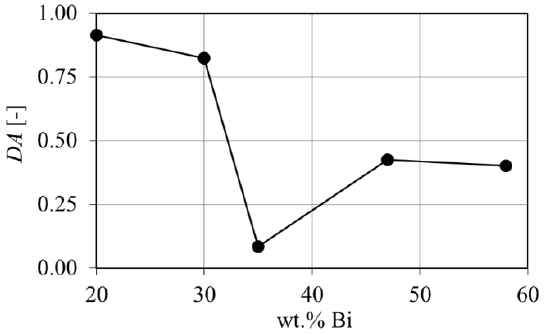
Figure 9. Figure 9. Calculated degree of anisotropy from µ -XCT measurements over composition of Sn-Bi